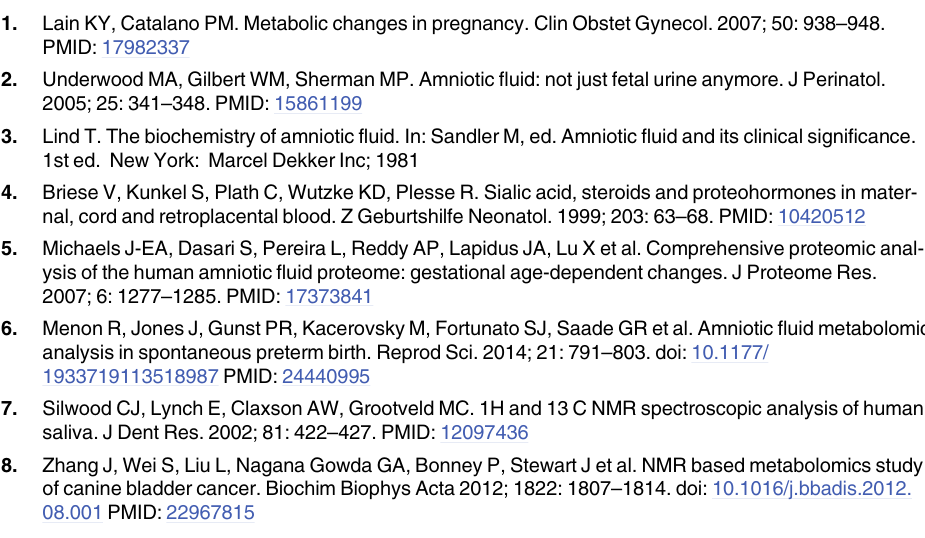
S1 File. All figures and tables of Supporting Information. Legend: Fig A. STOCSY